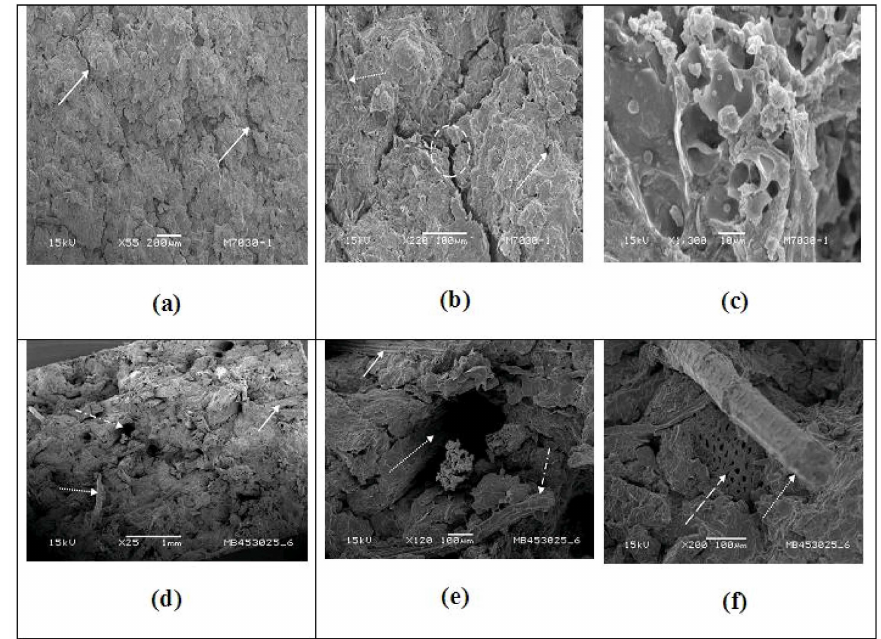
Figure 8. SEM photographs of 70 castor oil cake—30 recovered glycerol (RG) and its composite with banana fiber after the tensile test. ( a ) rough surface with cracks; ( b ) zoomed image of the region indicating the cracks shown in ( a ); ( c ) higher magnification of zoomed region of encircled region in figure ( b ); ( d ) panoramic view of the fractured surface of the composite showing rough surface, fibers and voids; ( e ) higher magnification of a region of ( a ) showing more cracks in the matrix, embedded failed fiber; ( f ) high magnification image showing pulled-out fiber with plasticizer coating and non-structured starch showing small polymorph